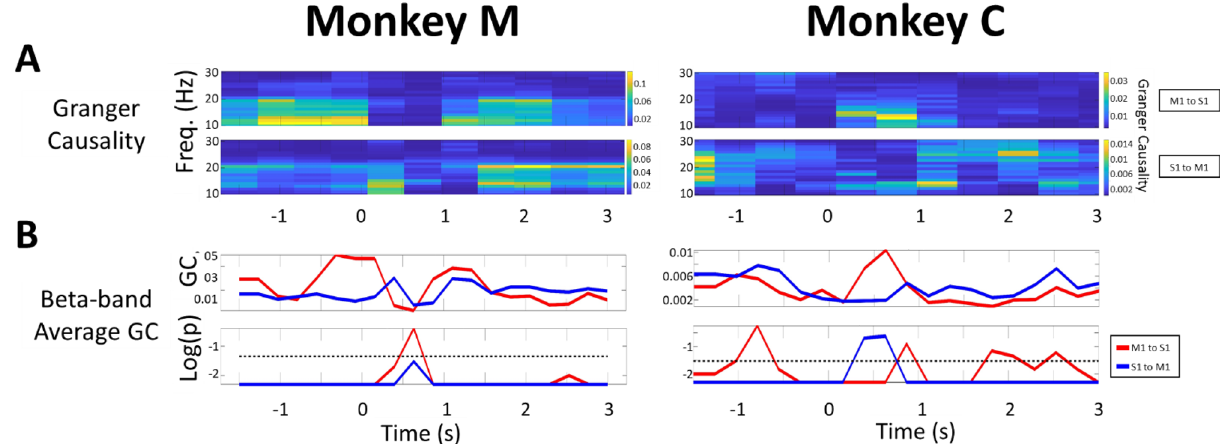
Figure 6. Granger Causality for a single S1–M1 LFP channel pair shows the interruption of beta-band Granger Causality from the onset of the SURPRISE EVENT at t = 0. Left: Monkey M. Right: Monkey C. Data is averaged across all trials (n = 51 for monkey M and n = 86 for monkey C). ( A ) Spectra-temporal S1–M1 LFP Granger Causality heat map indicates the bidirectional beta-band causality between S1 and M1 in both monkeys in the initial steady-state. Causality decreased significantly during the onset of the SURPRISE EVENT but recovered thereafter. Upper panel: Granger causality from M1 → S1. Lower panel: Granger causality from S1 → M1. ( B ) Upper panel: Averaged Granger causality across the beta-band (15–30 Hz) for a single LFP channel pair reflects the vanishing of the beta-band GC index at the onset of the SURPRISE EVENT. Once the animal found the new steady-state, the GC values gradually recovered. Lower panel: p-value in log 10 scale calculated from random permutation test (# permutations = 200). We chose a target α = 0.05 and used FDR correction for multiple testing. The black dashed line represents the log of adjusted α. Those GC indices with p-value above the dashed line were considered as statistically not